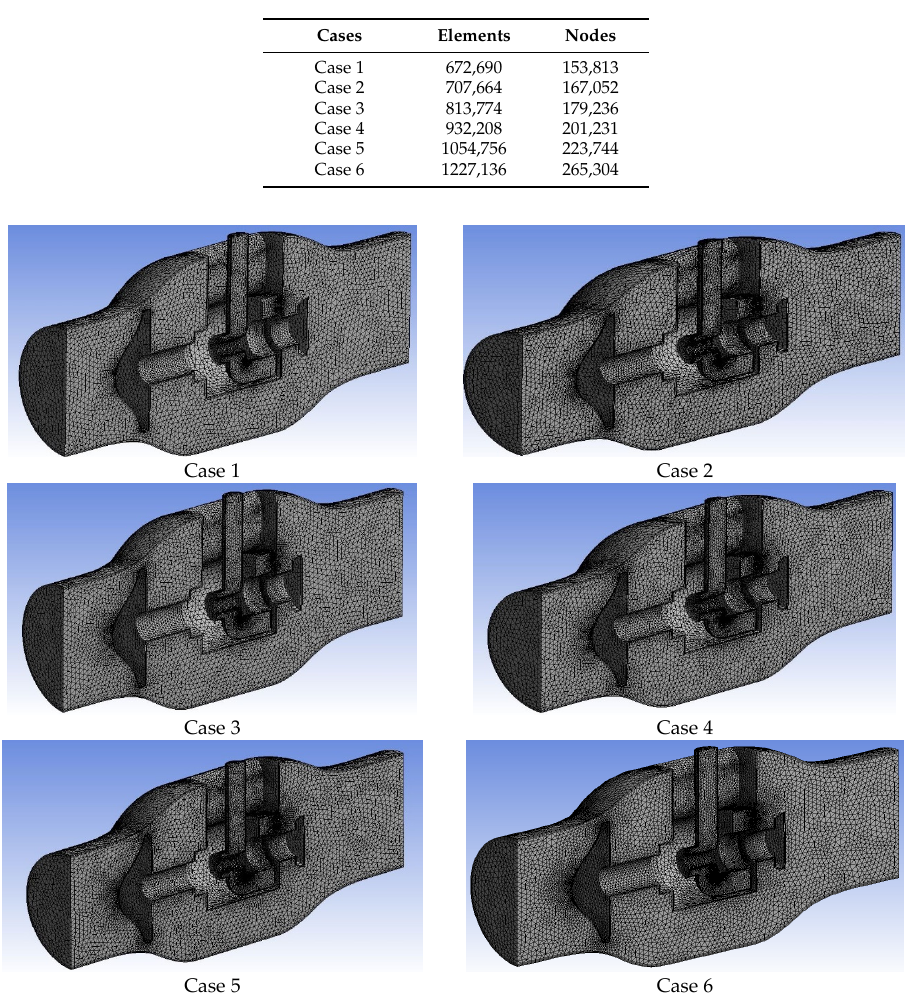
Figure 5. Cases of meshing that used in the Grid-independence test.